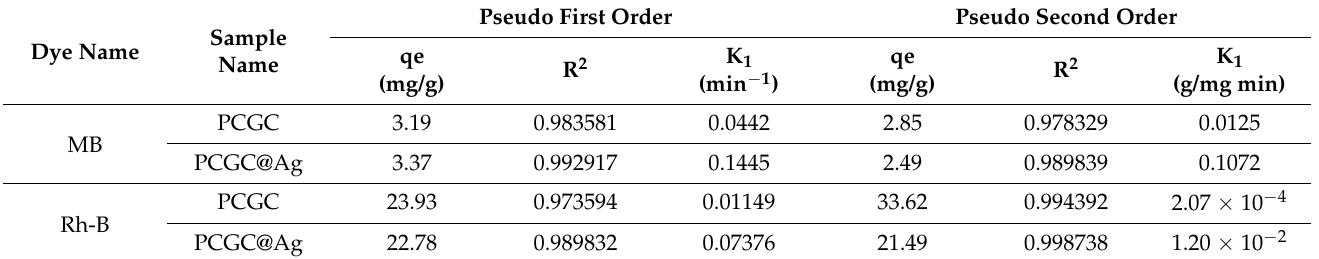
Figure 5. The photocatalytic degradation of model dyes (MB and Rh-B) using kinetics curves of the fabricated nanofibrous membrane PCGC@Ag: MB ( a , b ) and Rh-B ( c , d ) at 25 °C. Table 1. Summary of the photocatalytic and degradation kinetics studies.